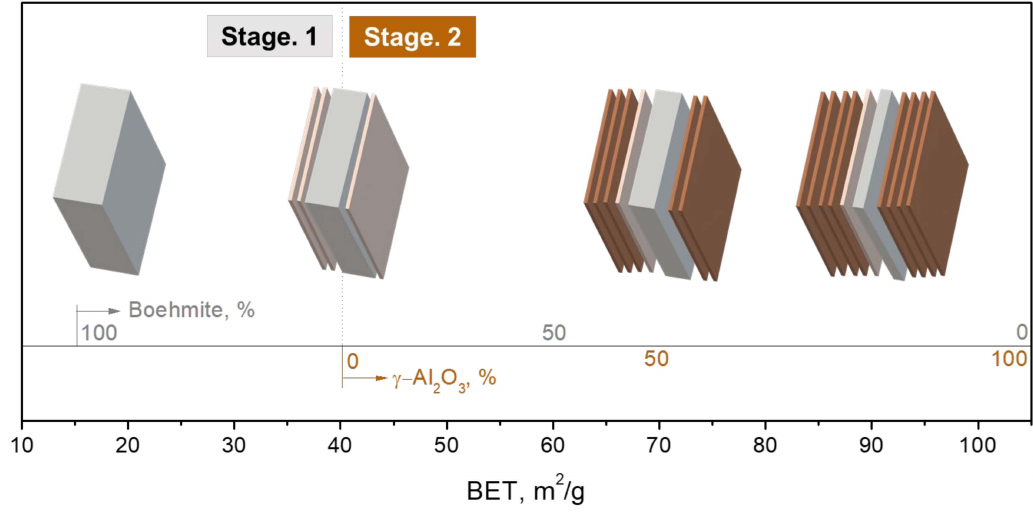
Figure 8. Schematic diagram of the powder exfoliation process at each